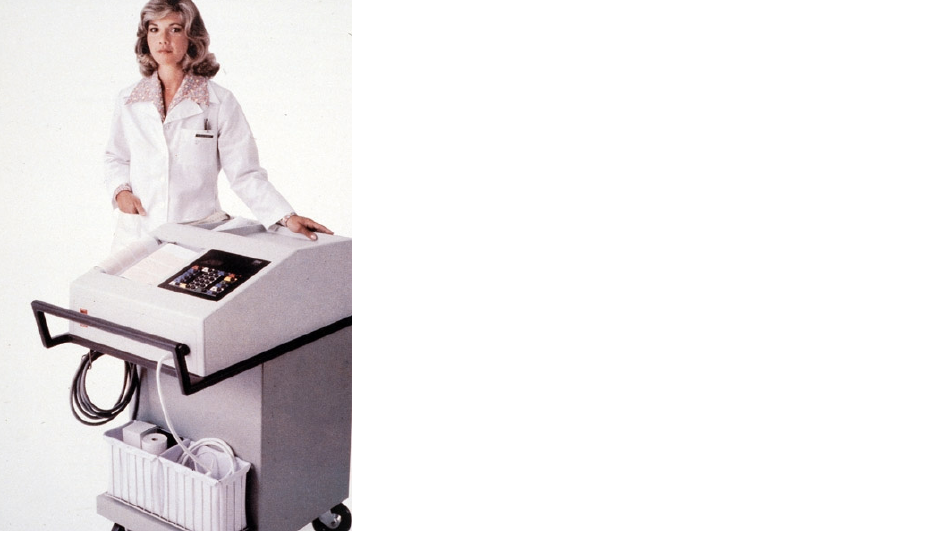
Figure 4. One of the earliest standalone electrocardiographs with automated ECG interpretation.